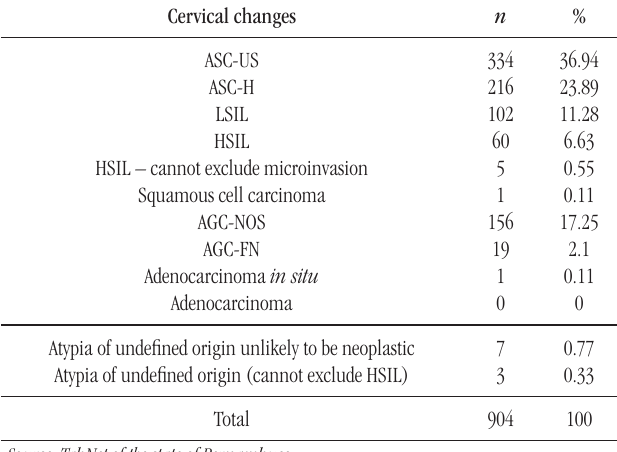
taBLE 1 − Frequency of cervical changes in the cytopathological exams of women from the municipality of Caruaru, Pernambuco, in the year